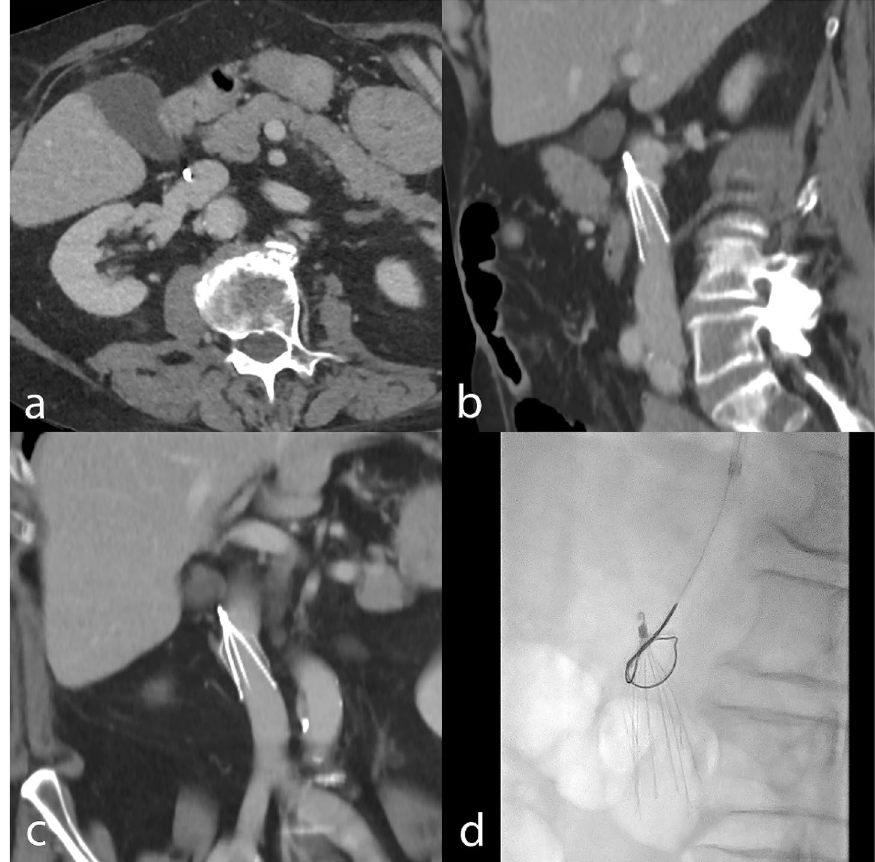
Figure 5. In a clinically eligible patient for IVCF retrieval, CT venography showed an embedded filter hook ( a ) due to a tilt visible both on sagittal ( b ) and coronal ( c ) reformatted images. Fluoroscopy image during the procedure shows unsuccessful attempt to retrieve the IVCF using a single-loop snare system ( d ). CT computed tomography, IVCF inferior vena cava